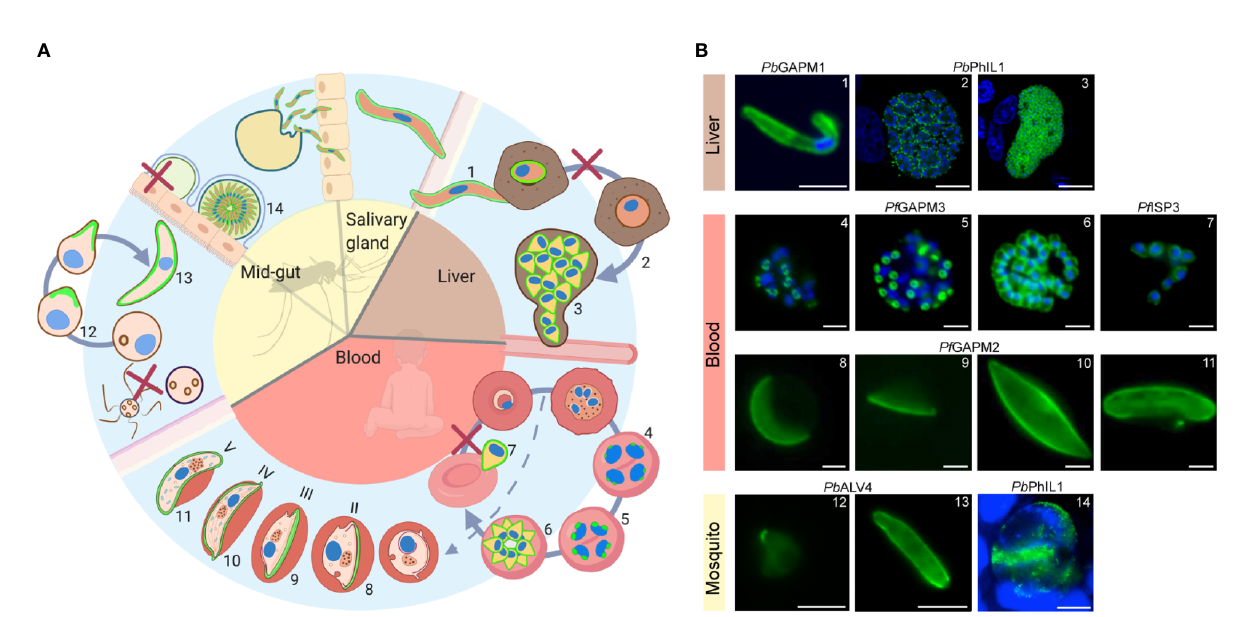
FIGURE 1 | IMC dynamics through the malaria parasite life cycle. (A) Schematic representation of the lifecycle through the mosquito and human host. The IMC in different stages is highlighted in green. IMC disassembly is marked with a red cross. (B) Fluorescent microscopy images showing the IMC (green) at different stages in the parasite lifecycle. Speci fi c IMC-GFP fusion proteins are indicated above the images. Blue; DAPI stain. Numbers in B refer to those in (A) 1 = Sporozoite (Kono et al., 2012), 2 = IMC biogenesis during liver cell schizogony (Saini et al., 2017), 3 = mature liver schizont (Saini et al., 2017), 4 – 6 = IMC biogenesis during schizogony in erythrocytes (Kono et al., 2012), 7 = free merozoites (Hu et al., 2010), 8 – 11 = developing IMC during gametocytogenesis (Kono et al., 2012), 12 – 13 = IMC biogenesis during ookinetogenesis (Kono et al., 2012), 14 = oocyst (Saini et al., 2017). Scale bars, 2 µm (micrographs 4 – 11) and 5 µm (micrographs 1, 12, 13, 14) 10 µm (micrographs 2,